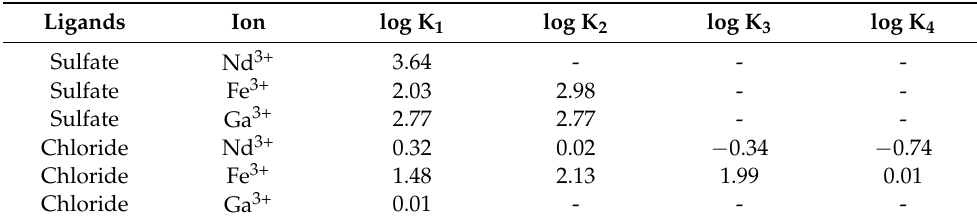
Table 7. Complex formation constants of the ions with sulfate and chloride ions